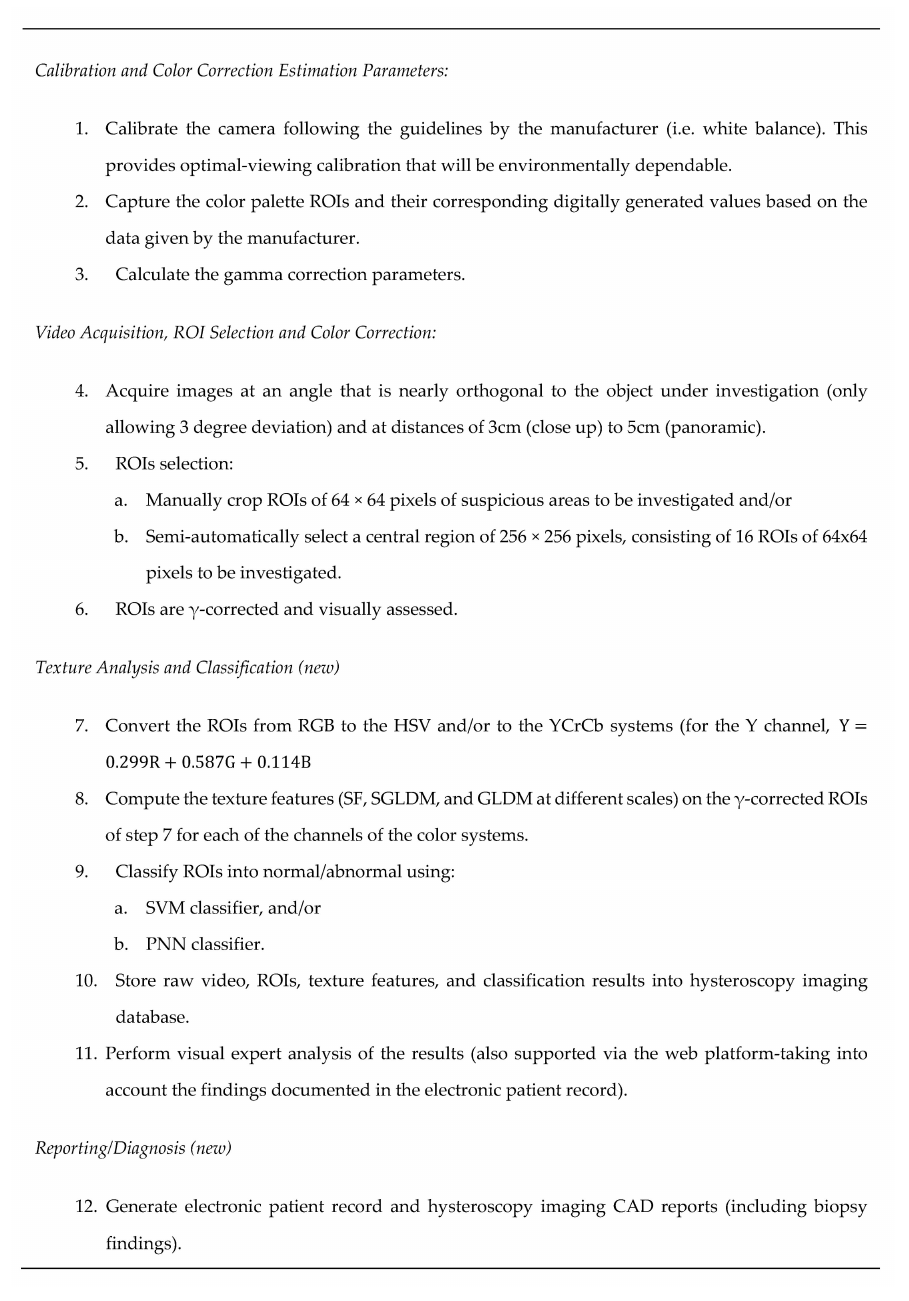
Figure 2. Hysteroscopy imaging CAD protocol covering image calibration and color correction, video acquisition, texture analysis and classification, and diagnosis. This protocol was updated from protocols previously published by our group in